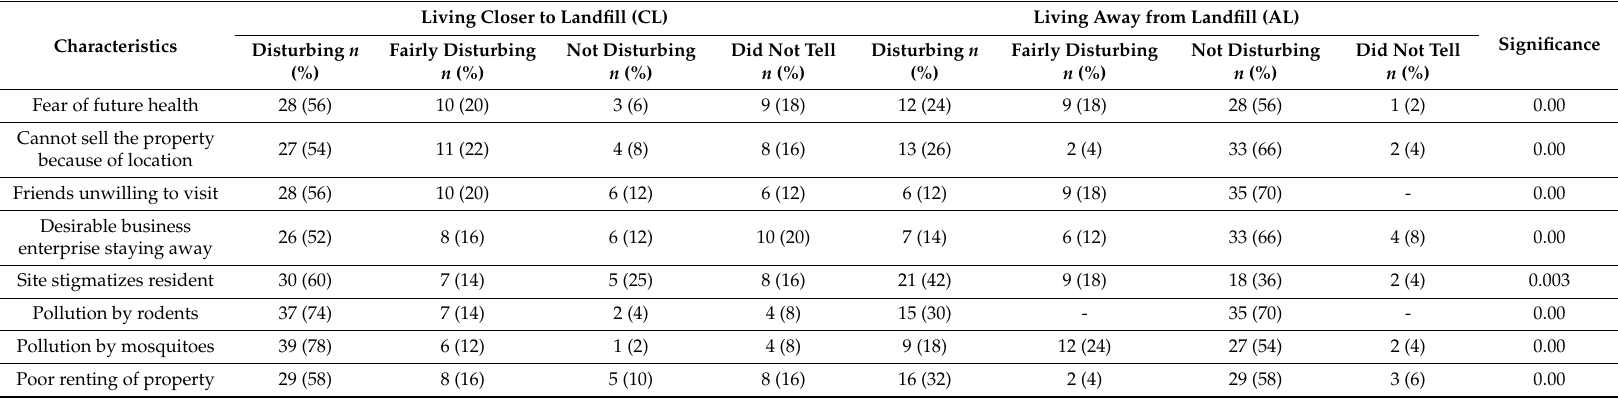
Table 4. Respondents’ ratings of how disturbing the external characteristics are observed by the participants living in both